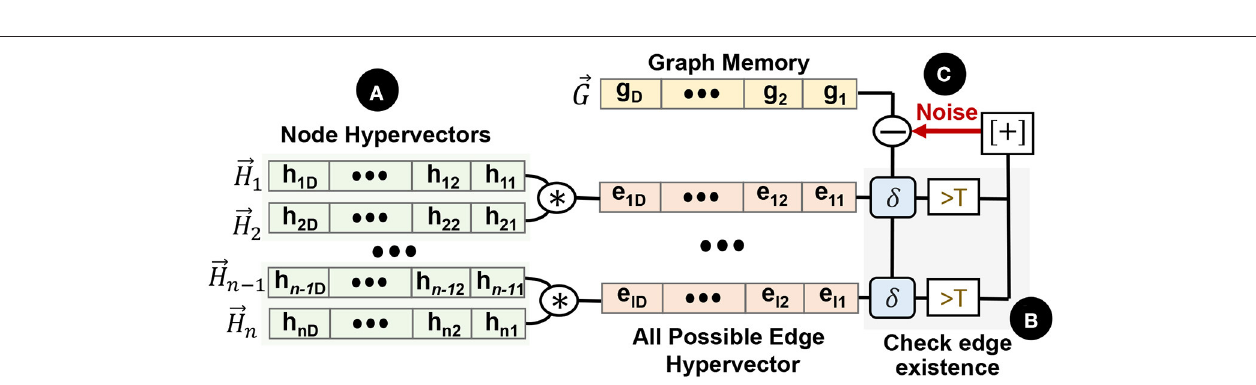
FIGURE 6 | Graph memory reconstruction: (A) create all possible edge hypervectors, (B) checking the existence of each edge on the graph, (C) iterative noise cancellation.